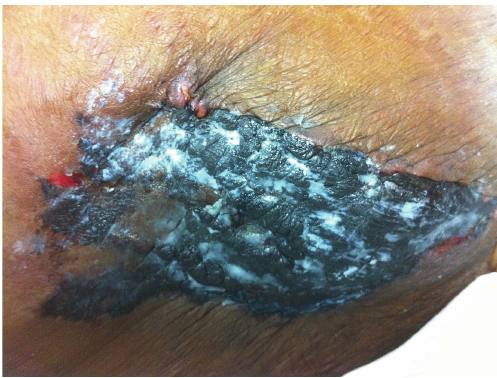
Figure 1: A large, necrotic, nonhealing ulceration on the abdomen of a patient with end stage renal disease, typical of a calciphylactic